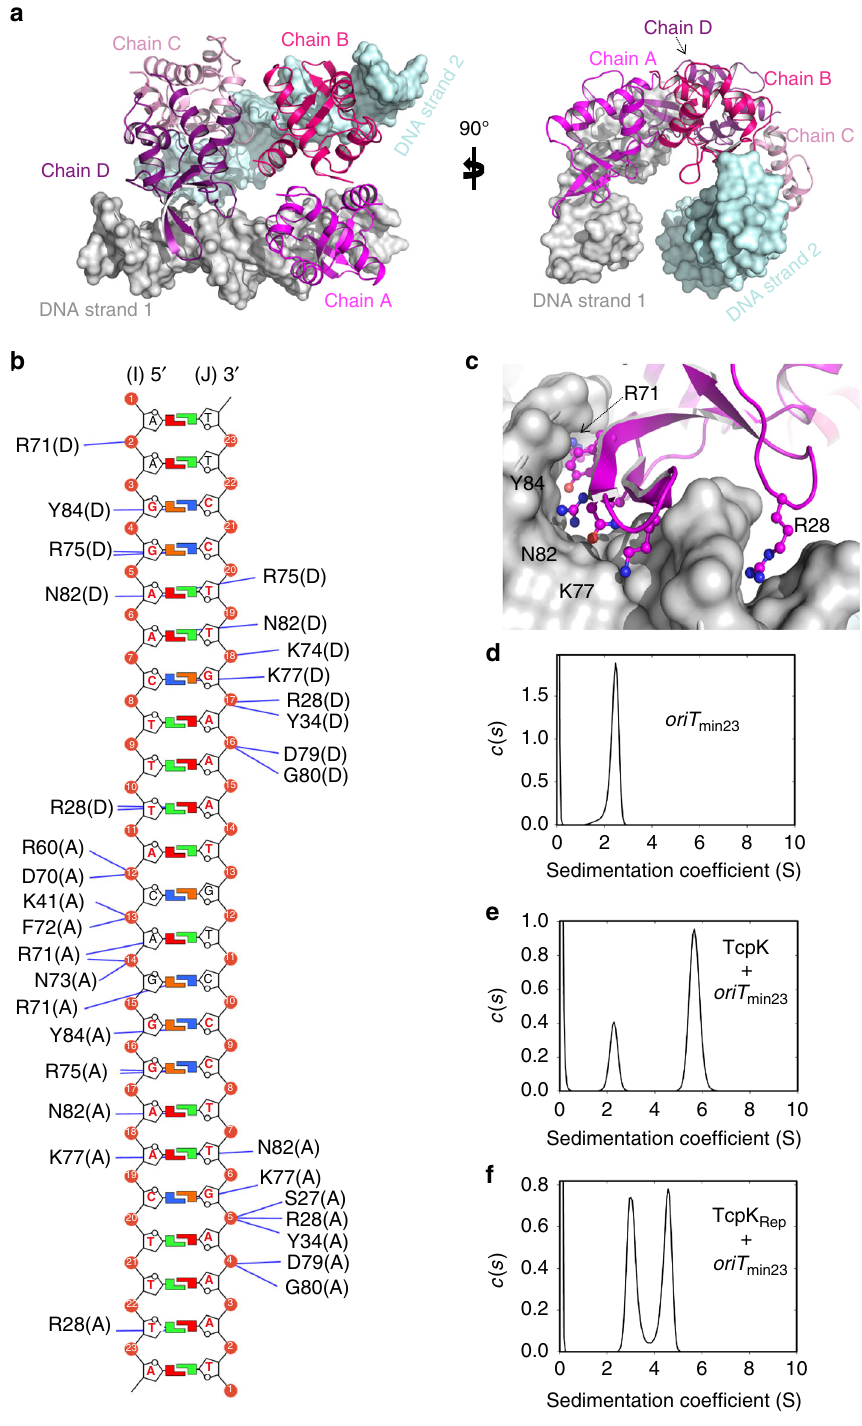
Fig. 3 The crystal structure of TcpK in complex with oriT min23 . a Ribbon representation of the overall structure of the complex. For clarity, only one half of the asymmetric unit is represented. Two orthogonal views along the vertical axis are presented. Each TcpK monomeric subunit is colored differently and DNA molecules are represented as surface structures. b Schematic representation of the contacts between TcpK and the DNA molecule. The respective chain IDs are presented in parentheses. For clarity, only hydrogen bond interactions are depicted and colored in blue, letters corresponding to the TcpK box nucleotides are colored in red. c Closer view of the DNA binding region. Selected residues of TcpK making hydrogen bond interactions with the DNA are represented as sticks. d Continuous sedimentation coef fi cient ( c ( s )) distribution for 2 μ M oriT min23 and e for 24 μ M TcpK in the presence of 12 μ M oriT min23 calculated from the best fi t to sedimentation data shown in Supplementary Figure 3d, e. f Continuous sedimentation coef fi cient ( c ( s )) distribution for 24 μ M TcpK μ M oriT fi t to the sedimentation data shown in Supplementary Figure Rep in the presence of 12 min23 calculated from the best